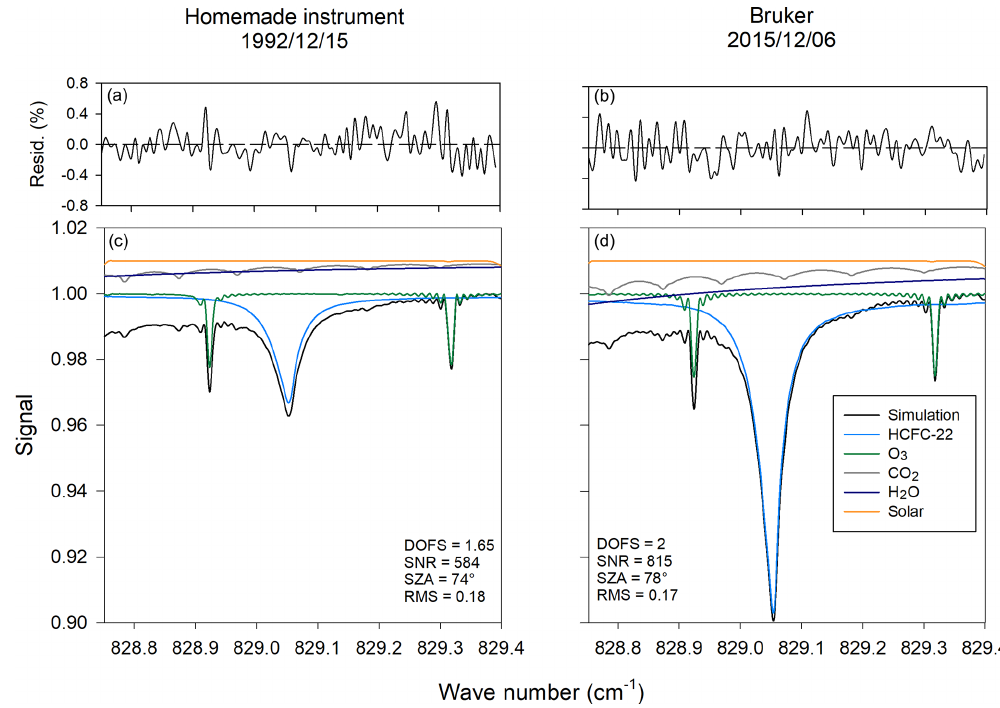
Figure 1. Simulations of the 828.5–829.4cm − 1 spectral window from spectra recorded by the homemade (15 December 1992) and the Bruker (6 December 2015) FTIR instruments at Jungfraujoch. CO 2 , H 2 O and solar spectra are offset vertically for clarity. Panels (a) and (b) display relative residuals (%) from the fits to the spectra. These fits are typical of the spectra database in terms of signal-to-noise ratio (SNR), root-mean-square error (RMS), degrees of freedom for signal (DOFS) and solar zenith angle (SZA), regarding their respective year. Note that the vertical scales in (c) and (d) correspond to only 10% of the signal amplitude.